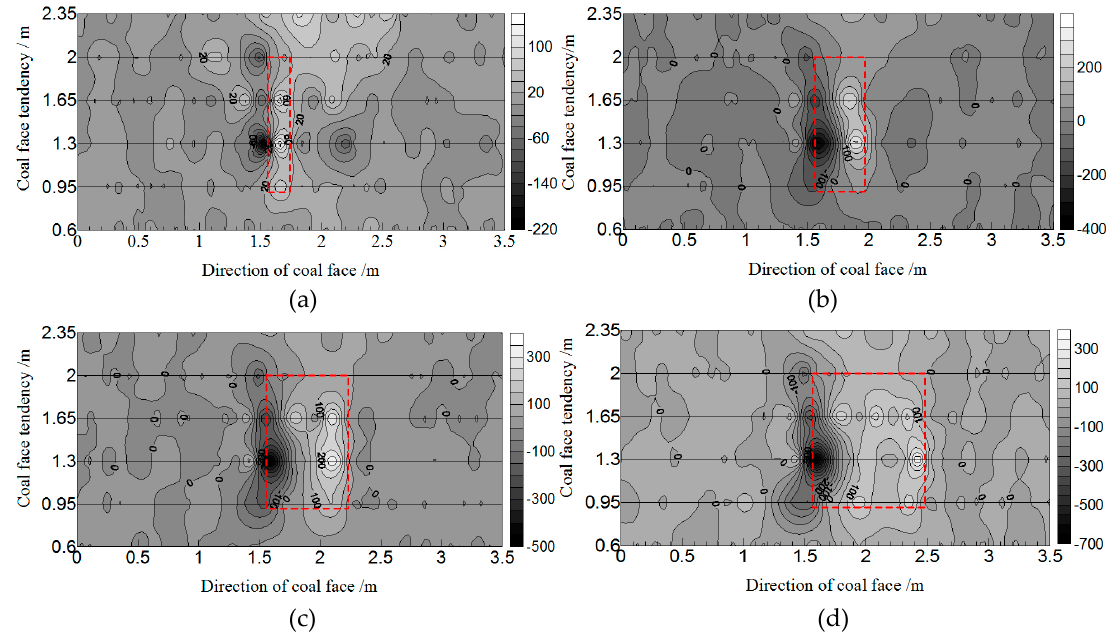
Figure 6. Stratum strain contour map of layer I: ( a ) the 2nd strip mined; ( b ) the 5th strip mined; ( c ) the 8th strip mined; and ( d ) the 11th strip mined (unit: 10 − 6 ).